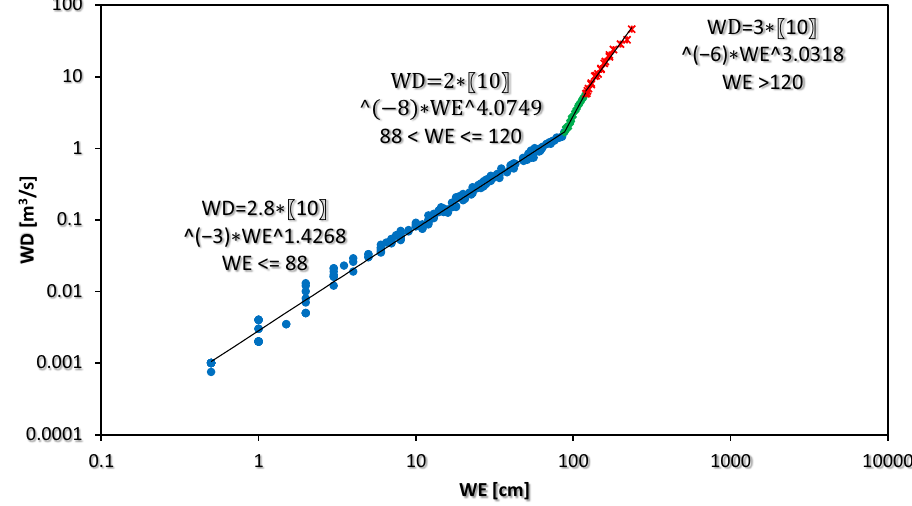
Fig. 2 The calibration curve of the Ain Berda hydrometric station